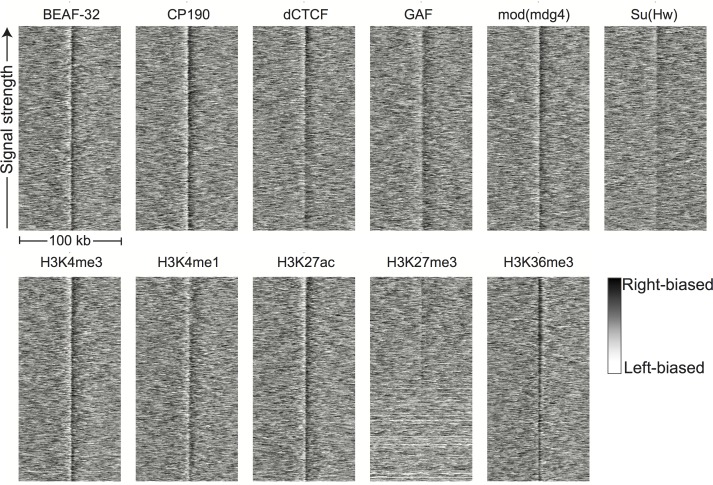
Directionality around peaks of genomic features.Hi-C directionality scores in 500 bp bins from aggregated nc14 data were plotted around the top 1000 (where available) peaks of the genomic features shown in Figure 3. The signature of a boundary is a region of left-bias (white) transitioning sharply to a region of right-bias (black).